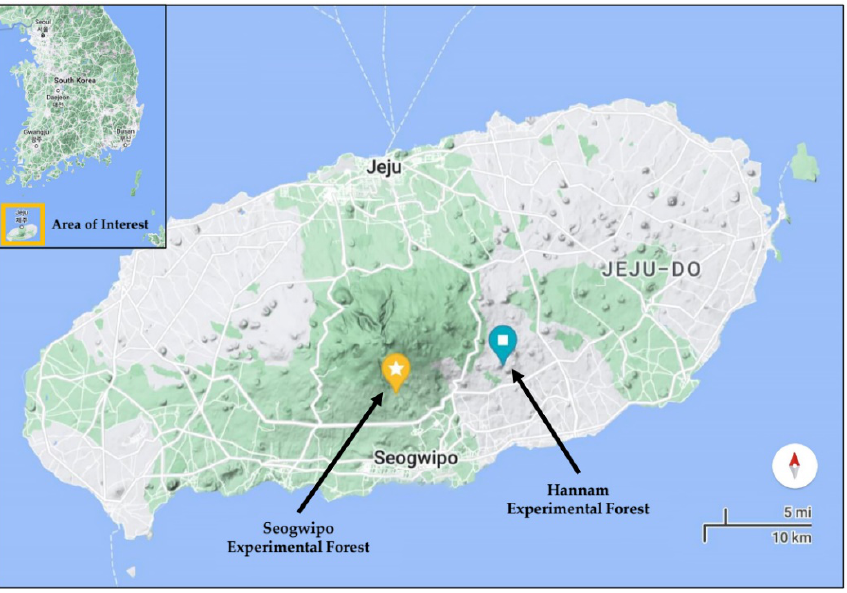
Figure 1. Image of the phytoncide-emission study sites on Jeju island, Korea.